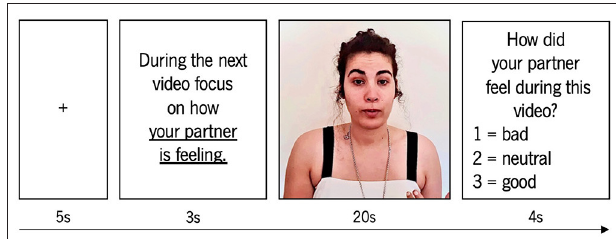
FIGURE 1 | Example of a trial on the Other